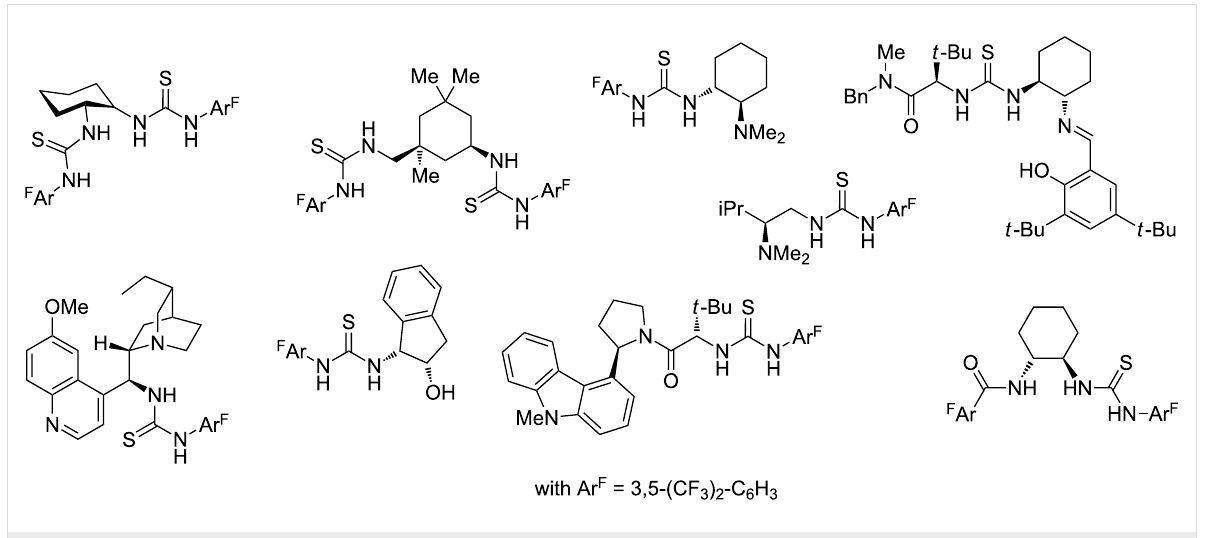
Figure 2: Structures of chiral mono- and bifunctional (bis-)thioureas that have been used as